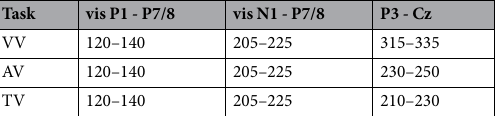
Table 3. ERP quantification. Time intervals used for ERP quantification in the SC condition (in ms after the STOP + CHANGE stimulus onset). VV = visual-visual task version, AV = audio-visual task version, TV = tactile-visual task